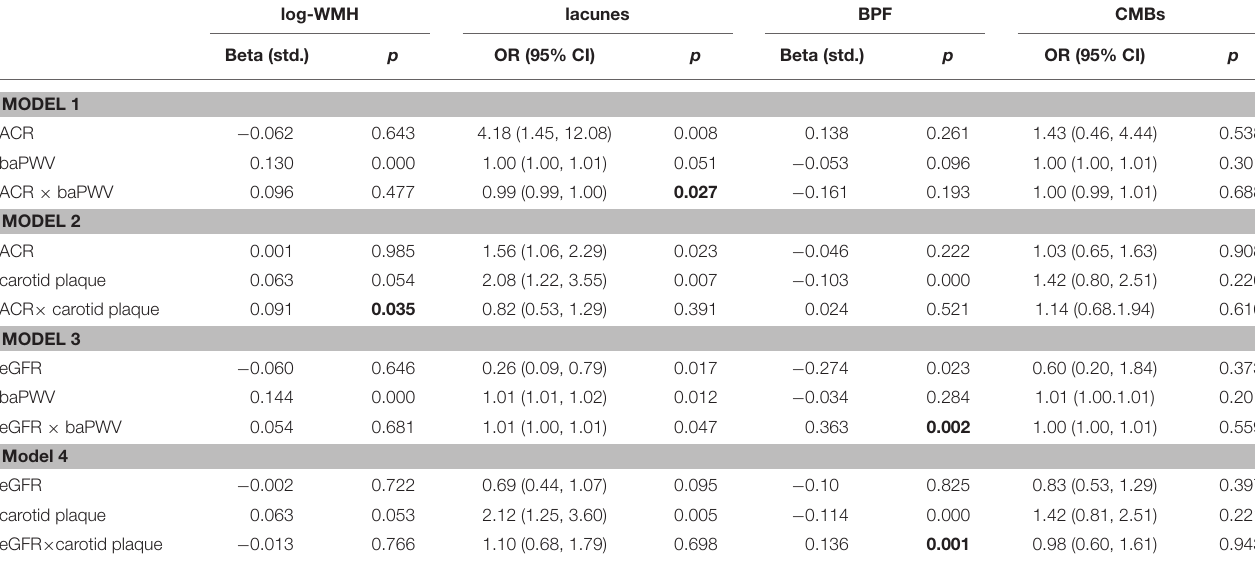
TABLE 3 | Interactions between Carotid plaques, BaPWV, Kidney injury measurements, and CSVD MRI Markers. log-WMH lacunes BPF CMBs Beta (std.) p OR (95% CI) p Beta (std.)